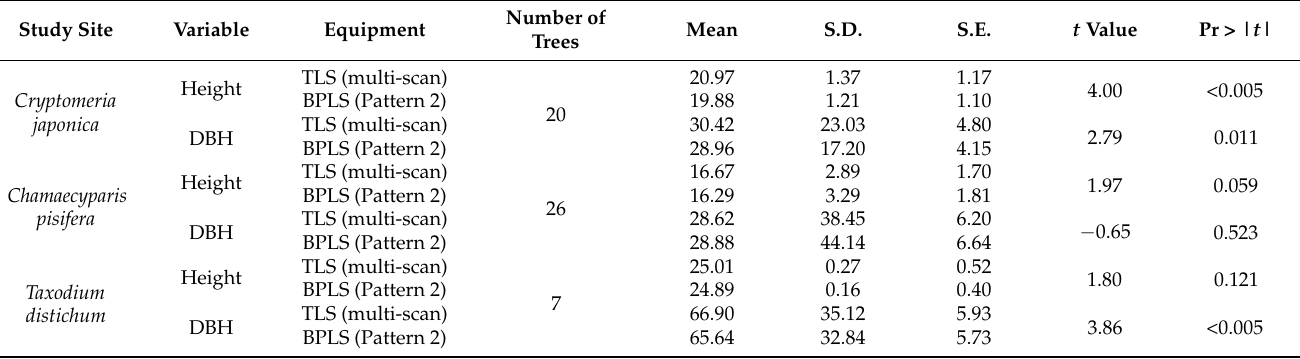
Table 10. Paired t -test analysis using the TLS and BPLS